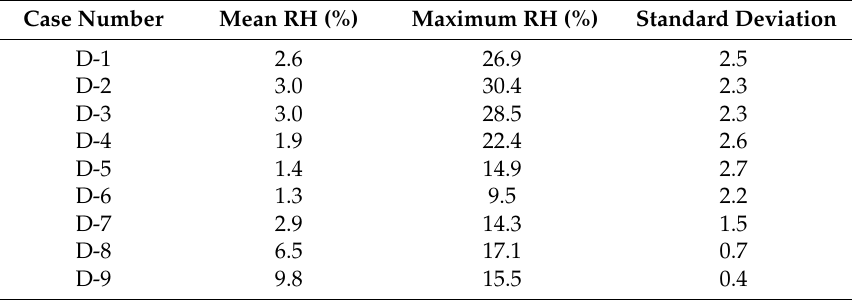
Table 2. Mean and maximum relative humidity (RH) values in FOUP for case